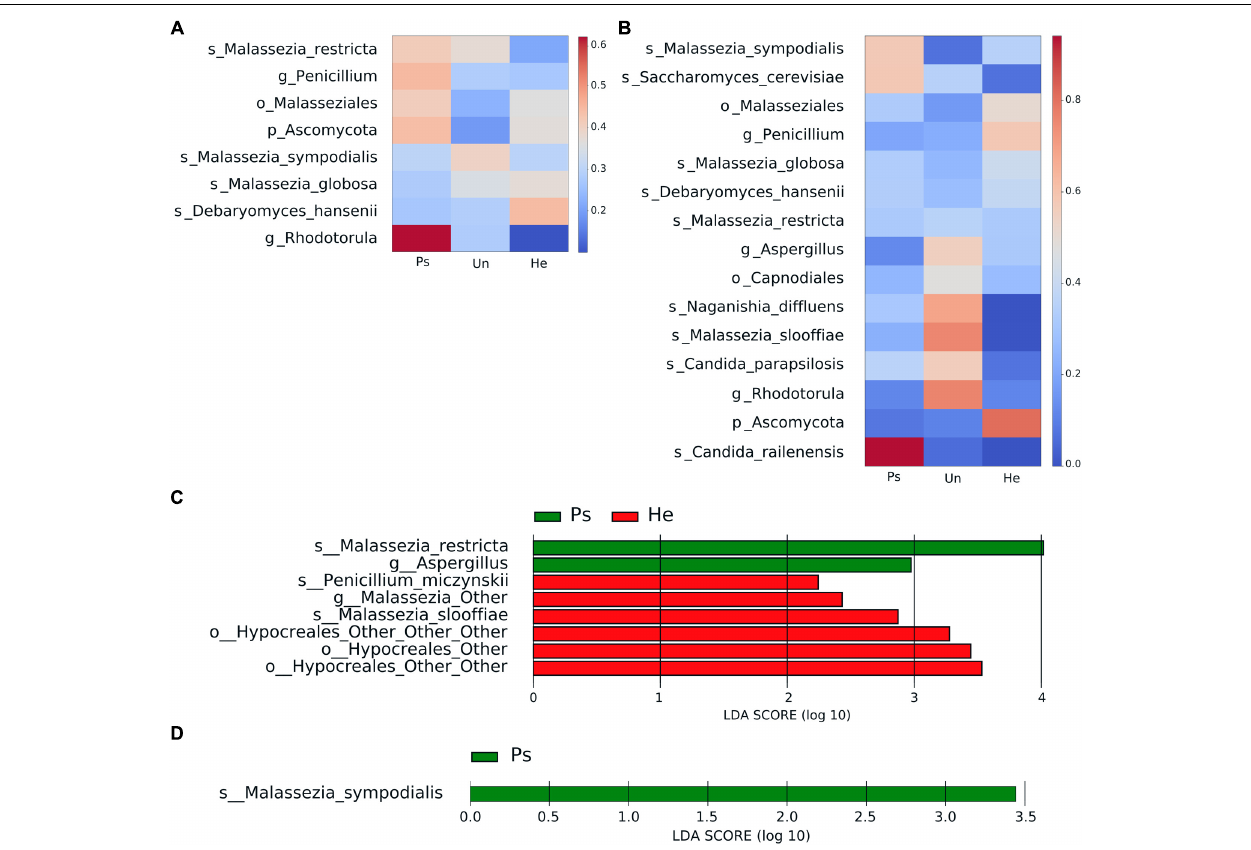
FIGURE 3 | Distinctive fungal patterns of swab samples related to disease status. Heat maps depict relative bacterial abundance in back (A) and elbow (B) samples. The cut-off abundance was set at 1%. The differences are color-coded by the relative abundance of bacteria. Red: high abundance; blue: low abundance. LEfSe analysis showing discriminative bacterial patterns in back (C) and elbow (D) samples in psoriatic, unaffected psoriatic, or healthy skin. Disease status: Ps, psoriatic; Un, unaffected; He, healthy